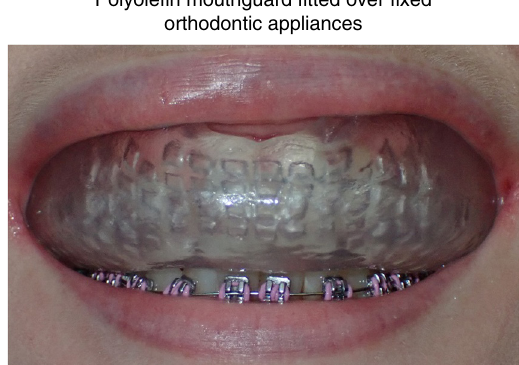
Figure 9. Polyolefin mouthguard fitted over fixed orthodontic appliances.